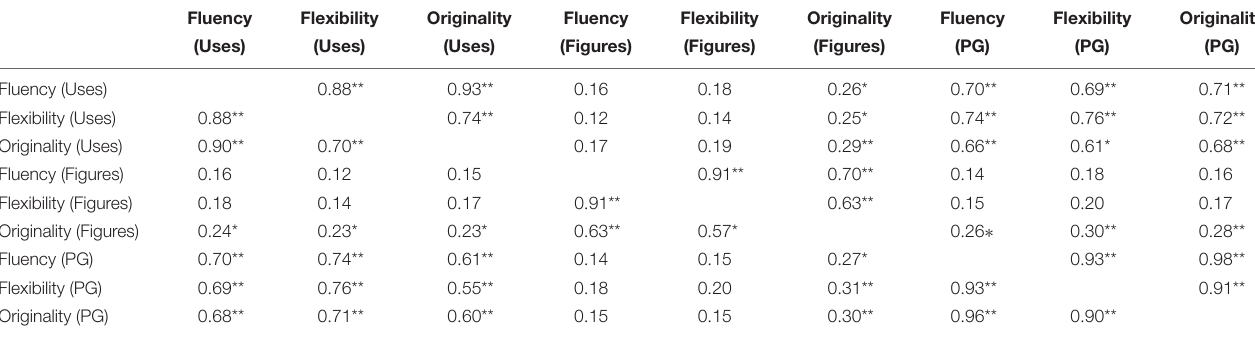
TABLE 4 | Correlations between study variables ( n =